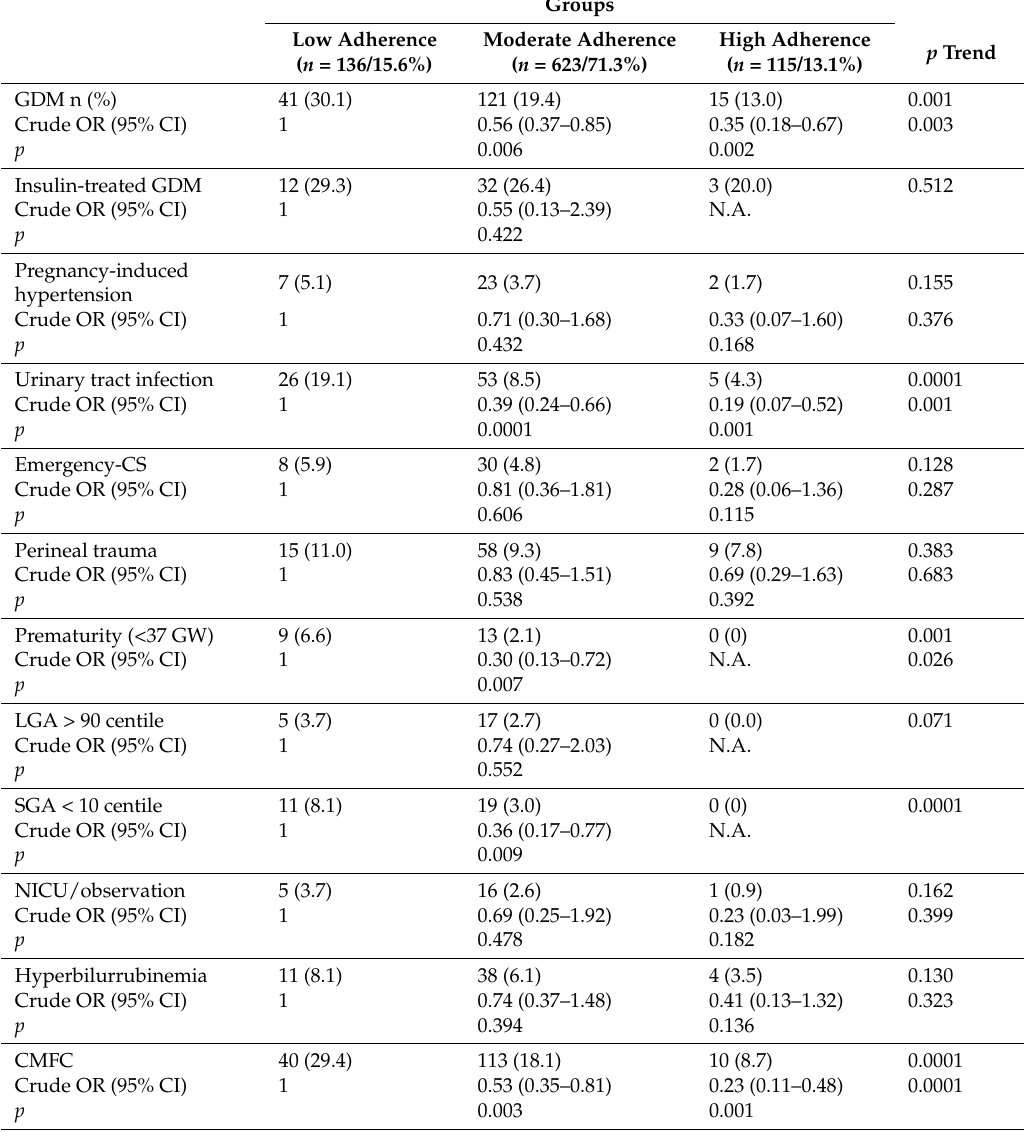
Table 5. Association between late first-trimester degrees of adherence to the six food targets and adverse